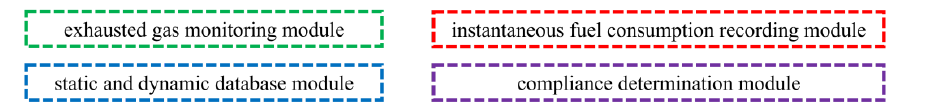
Figure 8. Regulation workflow for the compliance determination of NO x -emission intensity and sulfur content in fuel for voyaging ships.